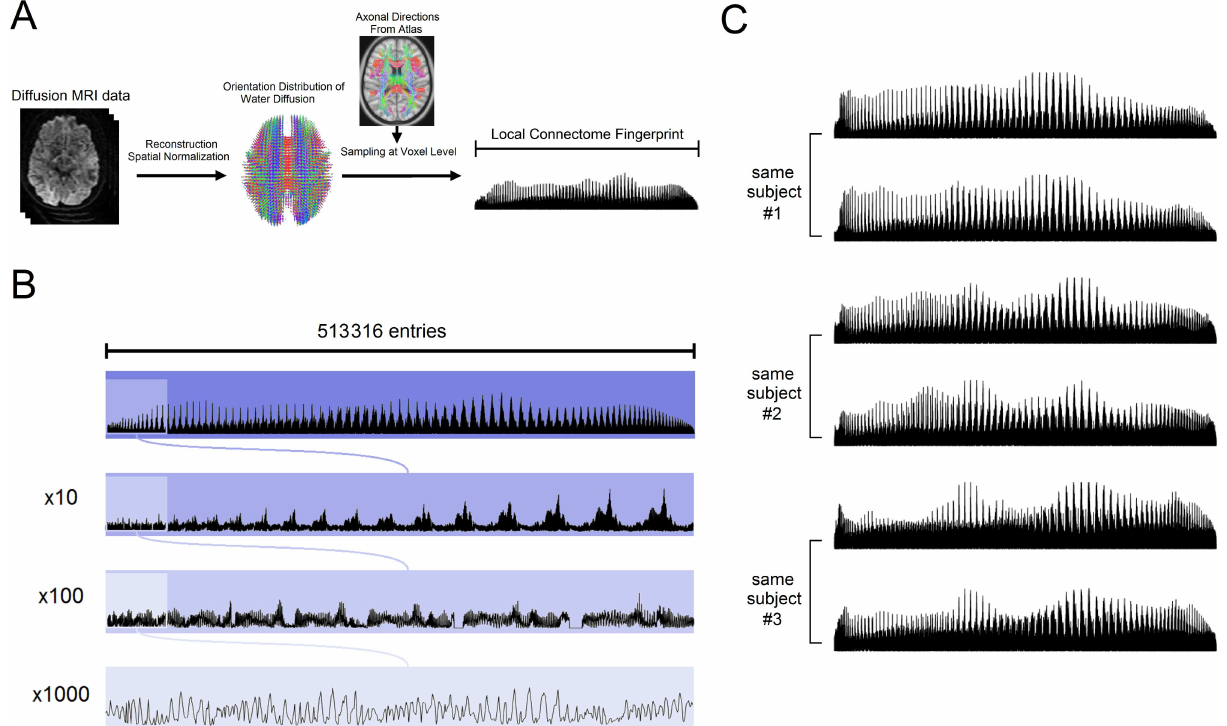
Fig 2. Local connectome fingerprinting. (A) Local connectome fingerprinting is conductedby first reconstructing diffusion MRI data into a standard space to calculatethe spin distribution functions (SDFs). A common fiber direction atlas is then used to sample the density of diffusing water along the fiber directions in the cerebral white matter. The sampled measurements are compiledin a left-posterior-superior order to form a sequenceof characteristic values as the local connectome fingerprint. (B) One local connectome fingerprint is shown in different zoom-in resolutions. A local connectome fingerprint has a total of 513,316entries of scalar values. (C) The local connectome fingerprint of subject #1, #2, and #3 and their repeat measurements (lower row) after 238, 191, and 198 days, respectively. At a coarse level, the local connectome fingerprint differs substantiallybetween three subjects, whereas those from the repeat scans show a remarkably identicalpattern, indicatingthe uniquenessand reproducibility of the local connectomefingerprint.